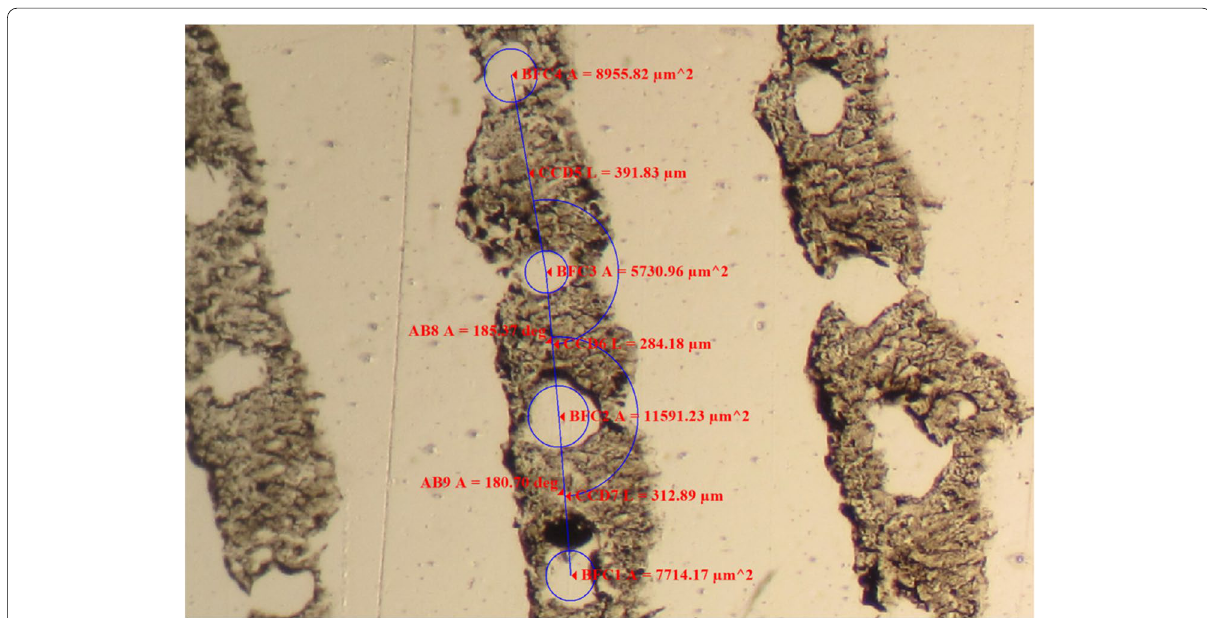
Fig. 3 Fingerprint pore area, pore center-to-center distance, and angle analyzed using Image Pro ®